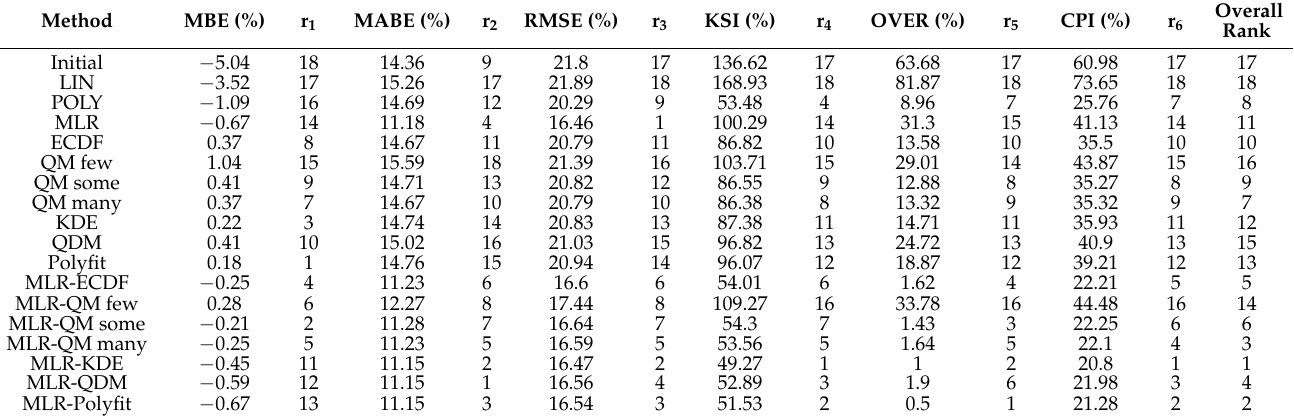
Table 2. Statistical metrics and ranking for estimated GHI in an all-sky condition. The rank is provided for each metric (r 1–6 ) and its overall